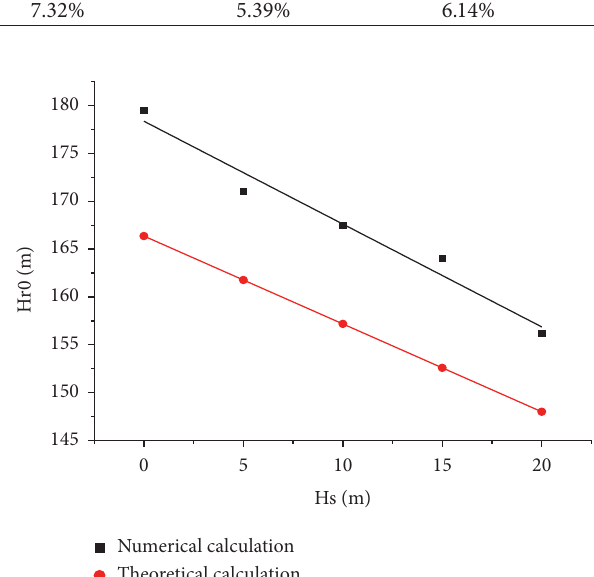
Figure 11: Comparison diagram of calculation